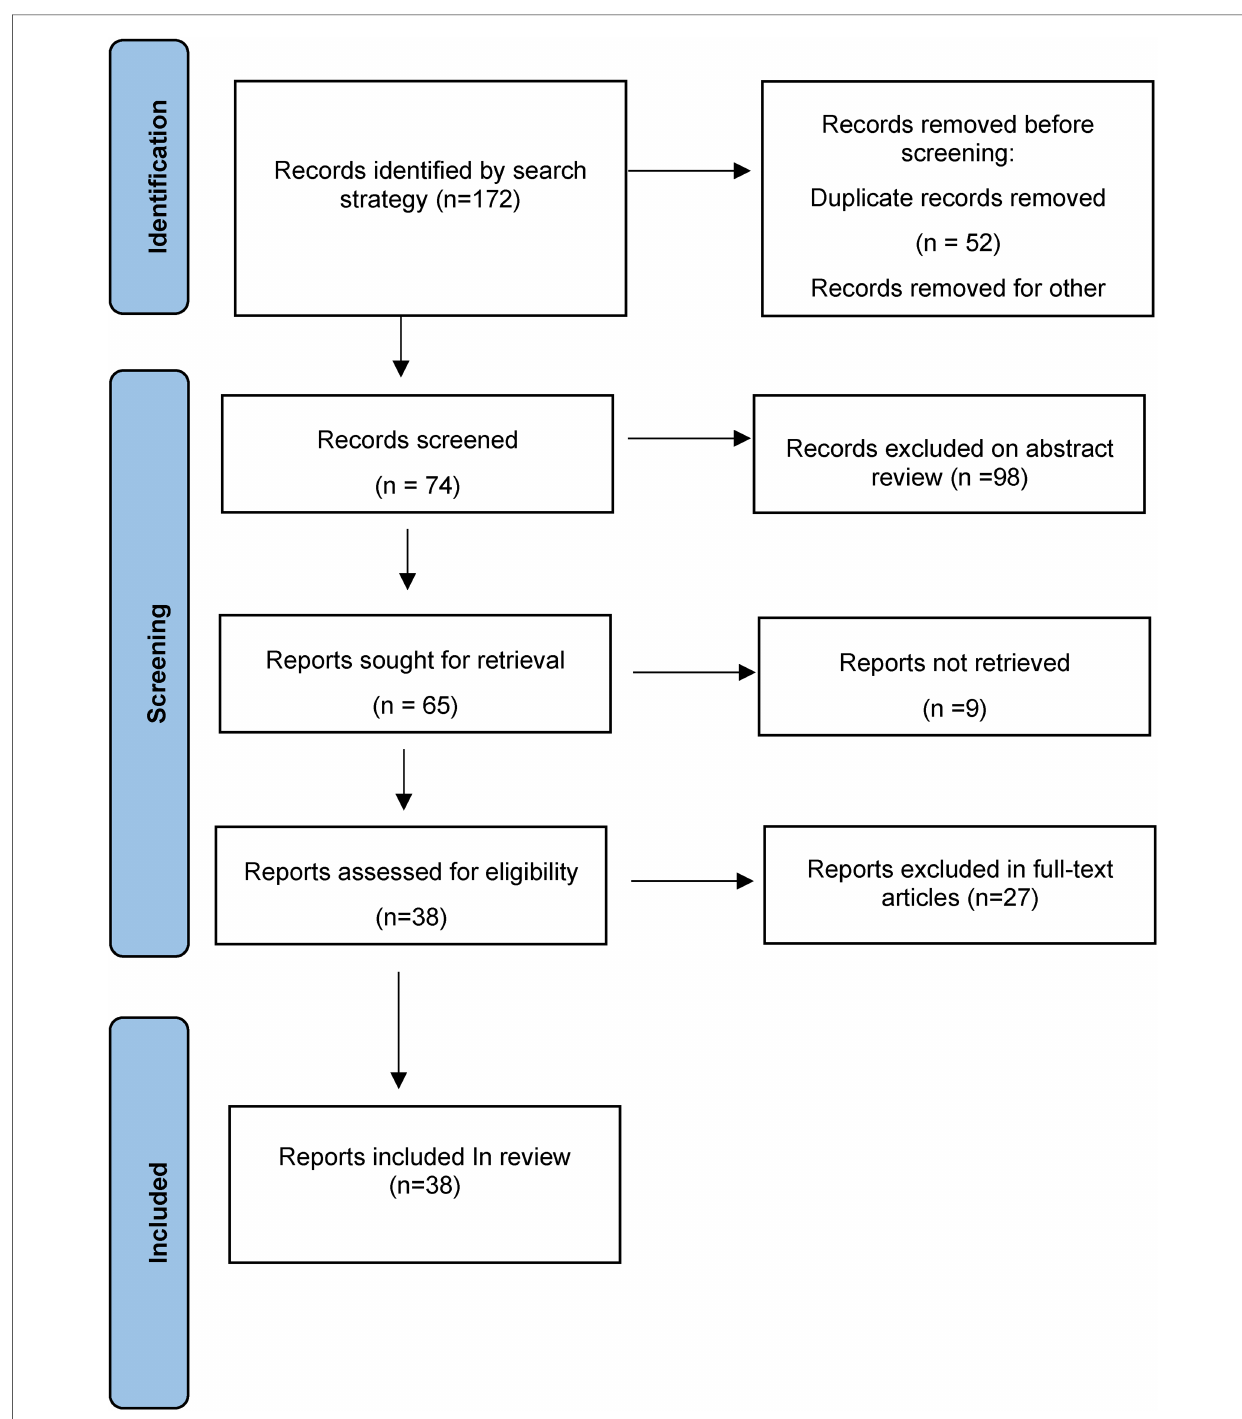
FIGURE 3 PRISMA fl ow diagram of the study